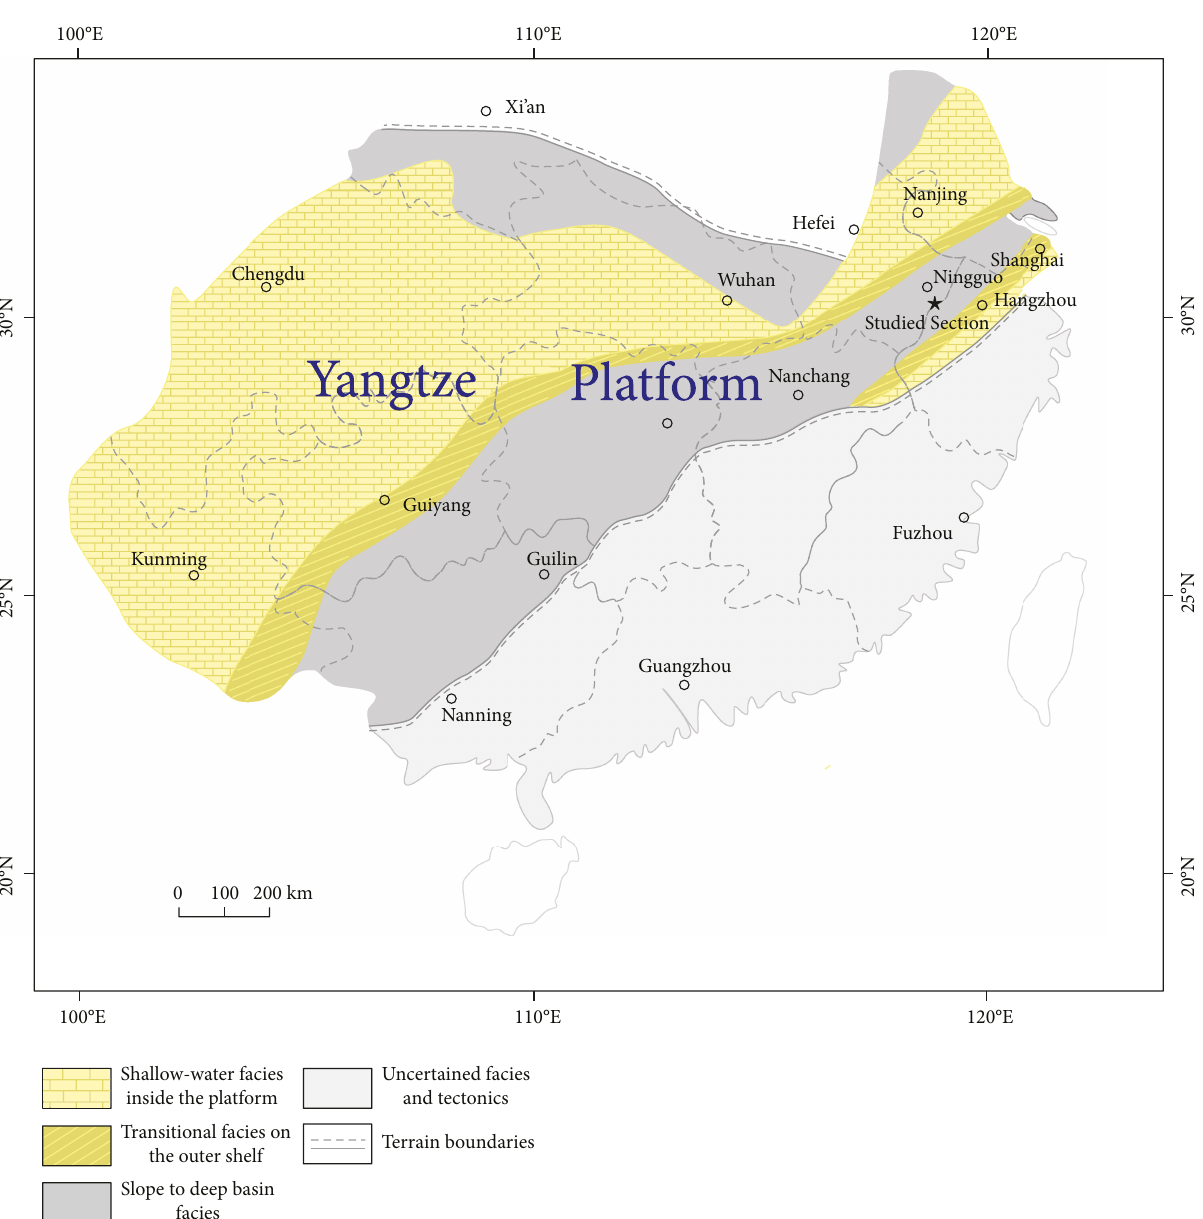
Figure 1: Simpli fi ed paleogeographic map of the Yangtze platform during the Cambrian (after